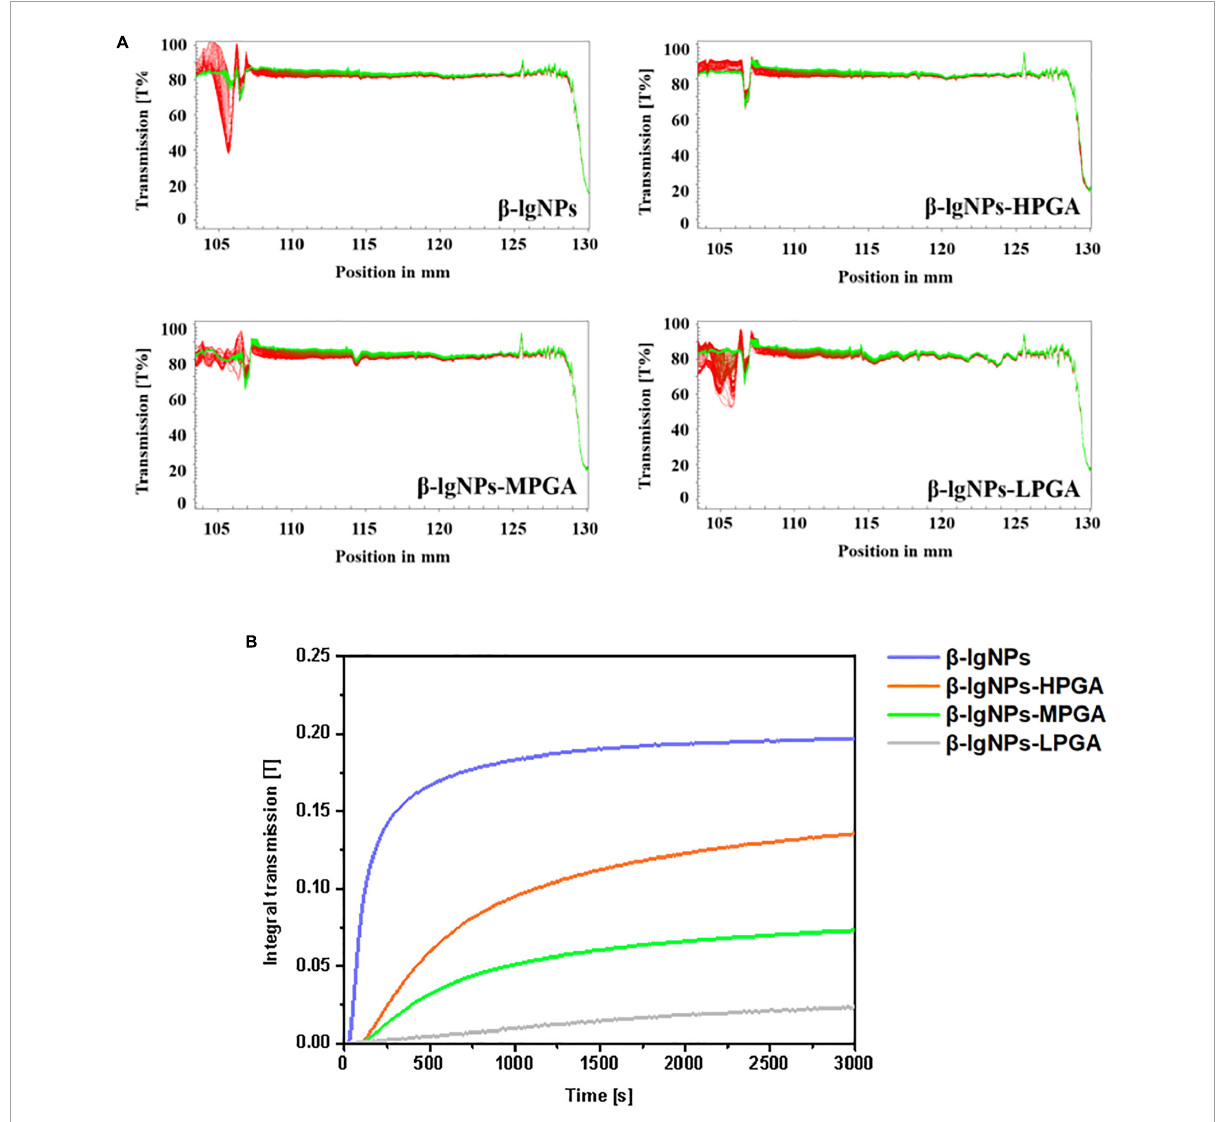
FIGURE7 The integral transmission (A) and time-dependent integral transmission profiles (B) of PGA- β -lgNPs complexes with different PGA M (w) as a function of